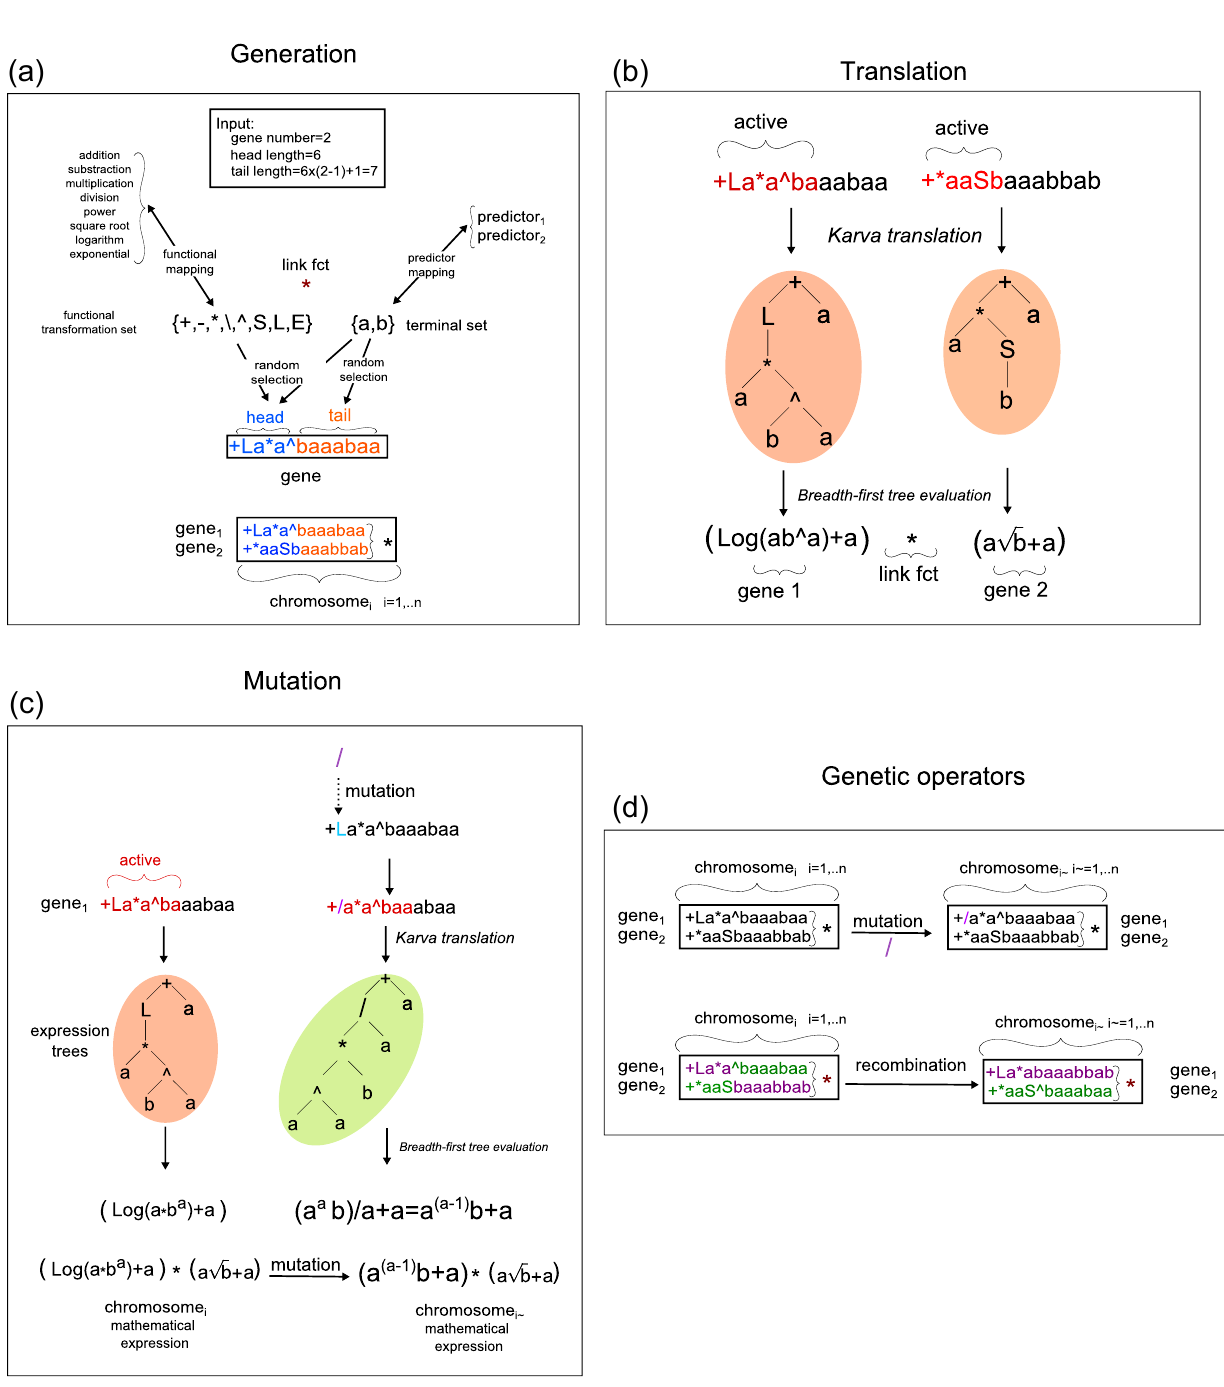
Figure 3. GEP evolution process components. (a) Initial random generation of genes for creating chromosomes, the individuals evolved by GEP. (b) GEP internal translation process from strings to expression trees and mathematical expressions. (c) Changes made in the mathematical expression when applying the mutation operator to the genes of a GEP individual. (d) Types of genetic operators for changing the GEP evolution